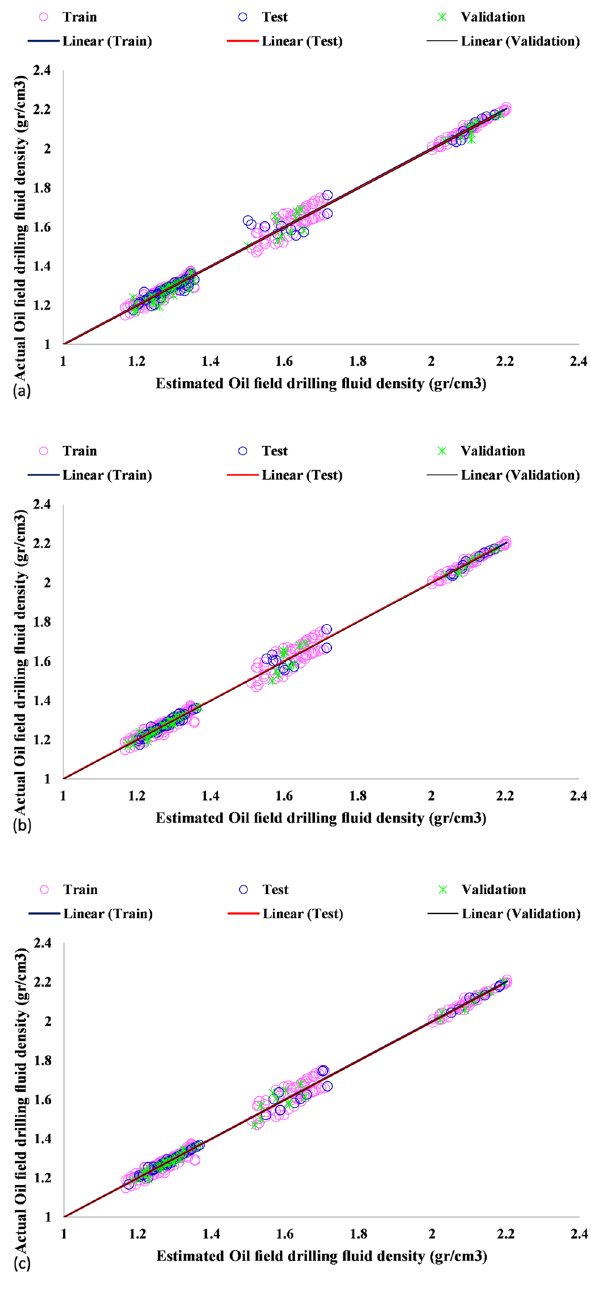
Figure 5. Regression plots for the prediction of drilling fluid density using ( a ) GA-LSSVM, ( b ) ICA-LSSVM, and ( c ) PSO-LSSVM models in the training, validation and testing